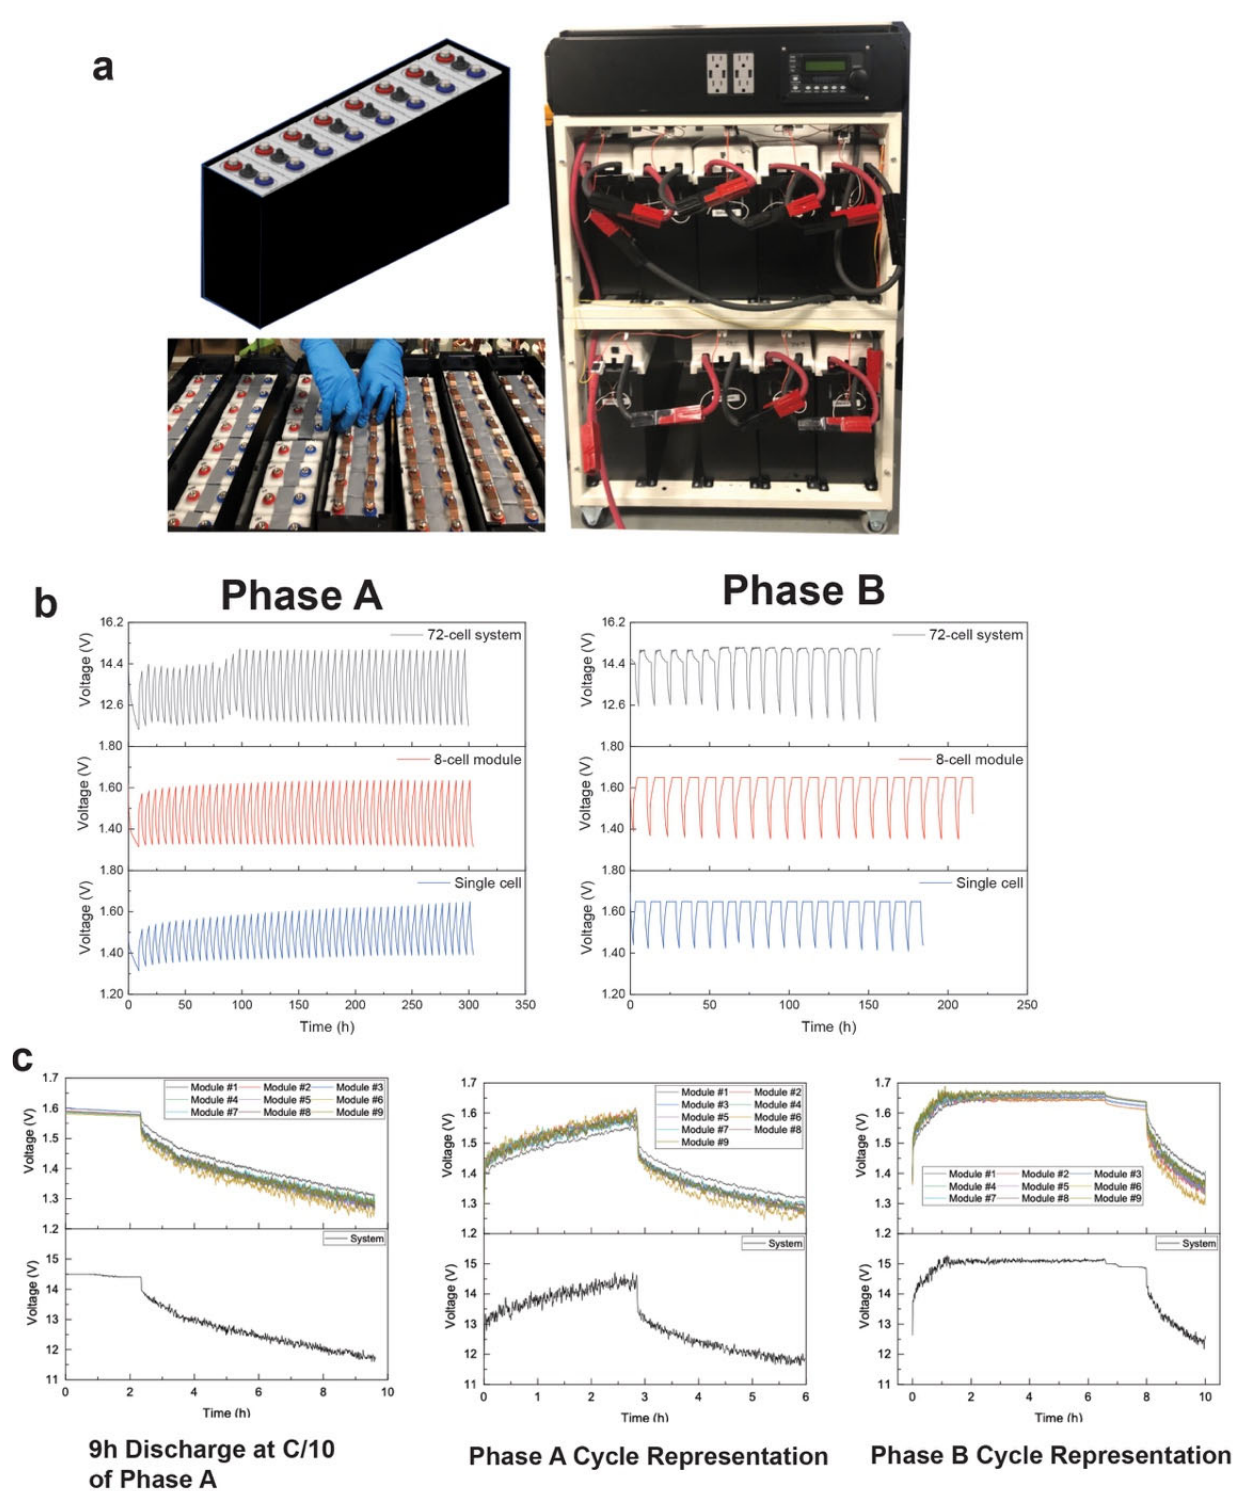
Figure 17. ( a ) A 2 kWh cube system constructed at UEP containing 72 prismatic cells filled with hydrogel electrolyte. ( b ) Comparison of a single prismatic cell, a module containing 8 cells connected in parallel and the 2 kWh system in Phase A and Phase B cycling regimes. ( c ) Comparison of the voltage curves of each module and the overall system at different stages—the first 9 h discharge at C/10 in Phase A, a representative Phase A cycle and a representative Phase B cycle.